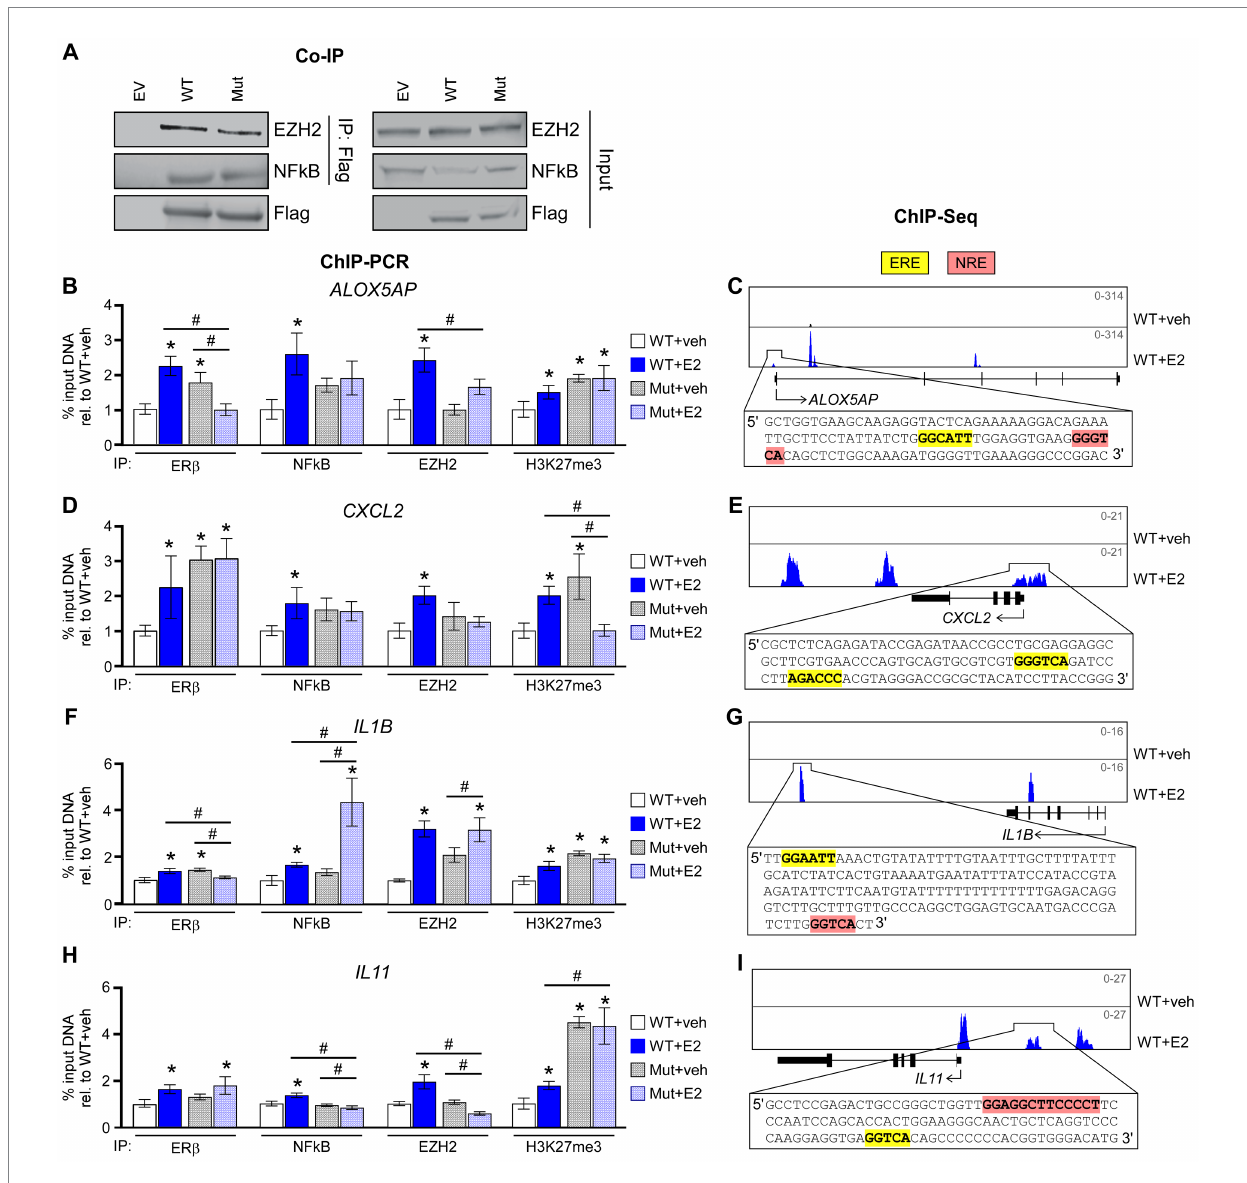
FIGURE 4 ER β DBD-Mut interacts with NF κ B and EZH2 but fails to repress NF κ B target gene expression. (A) Co-immunoprecipitation for WT ER β and Mut ER β followed by western blotting for EZH2 and NF κ B in HEK293T transfected cells. Inputs, and transfections with empty expression vector, are shown as controls. (B,D,F,H) ChIP-PCR for ER β , NF κ B, EZH2, and H3K27me3 enrichment at known ER β /NF κ B binding sites in close proximity to NF κ B target genes following dox exposure and indicated treatments of WT ER β and ER β DBD-Mut (Mut) expressing MDA-MB-231 cells. Scale shown as % input